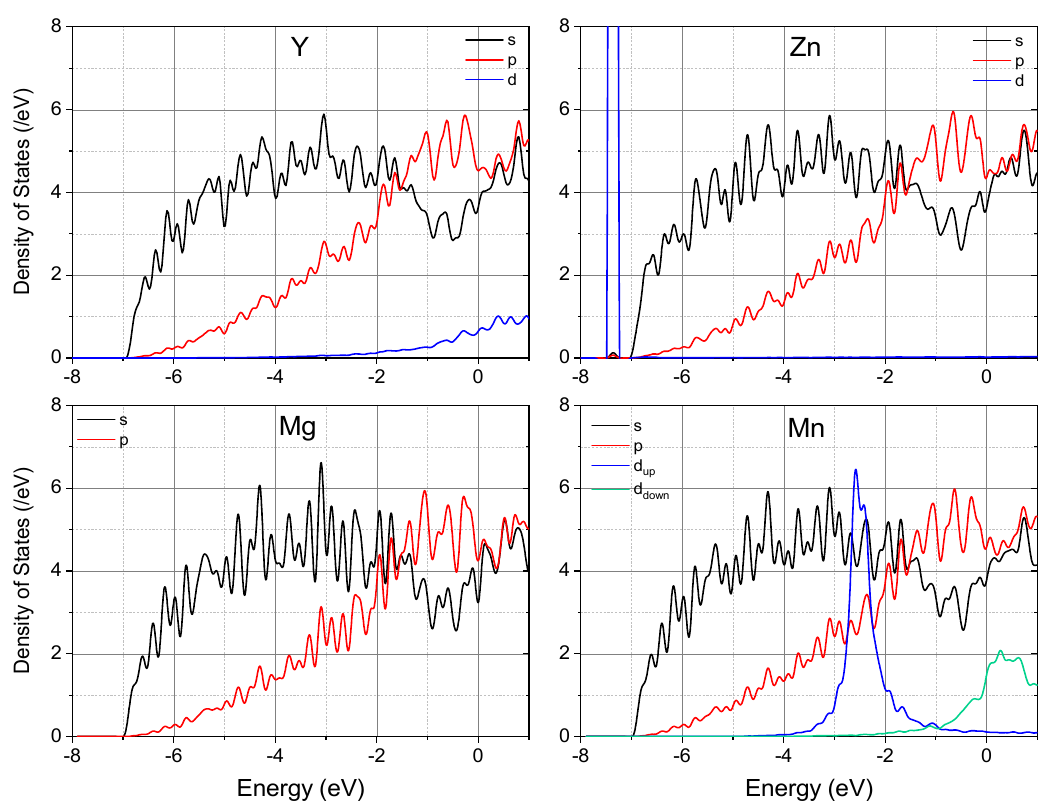
Figure 3. The partial density of states (PDOS) of the supercell with and without segregation of al- loying elements at the ( 2 114) twin boundary in Mg. Note that the spin-up and spin-down d states of Mn are colored differently. The Fermi energy is set to zero.